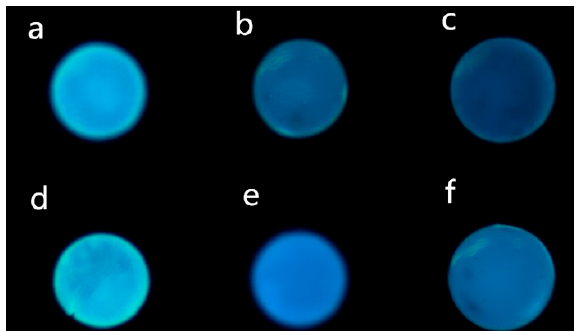
Figure 7. Images of MIPs (for a – c , the concentrations of bacteria were 0, 10 3 , and 10 5 CFU mL − 1 ) and NIPs (for d – f , the concentrations of bacteria were 0, 10 3 , and 10 5 CFU mL − 1 ) adsorbing different concentrations of bacteria.